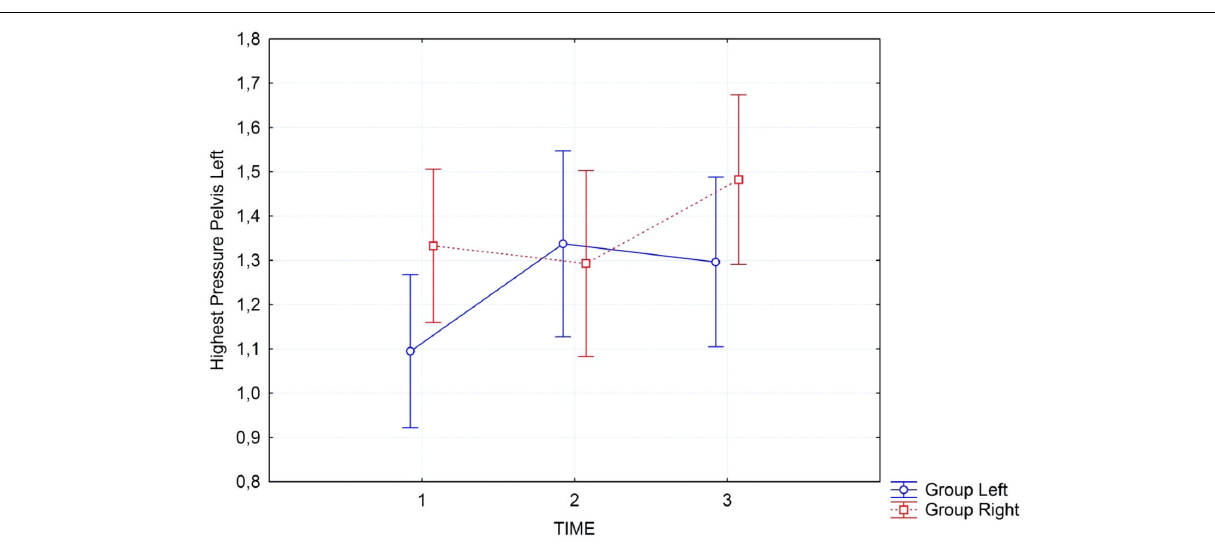
FIGURE 4 | Interaction graph of “highest pressure” in the pelvis region on the left side of the body, for the two groups separately: group left (blue line) started with left side; group right (red line) started with right side. Error bars refer to 95% confidence